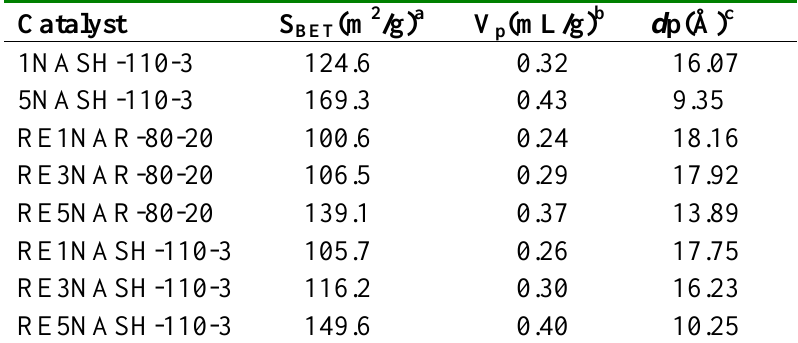
Table 2. Specific surface area and pore structure analysis of the Ni/Al HTlcs and Ni-based